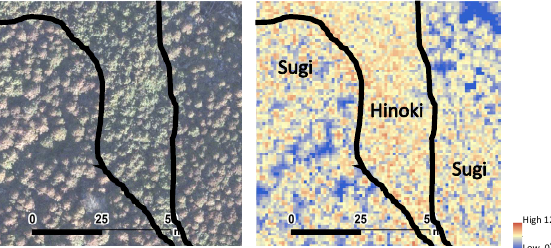
Figure 2. Topographic openness extracted from DSM